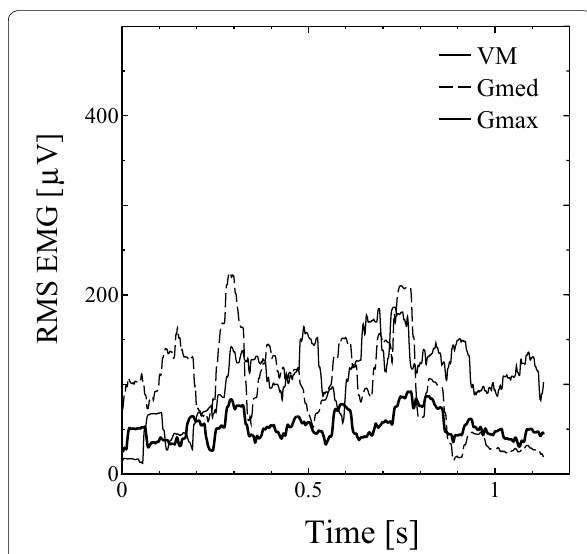
Fig. 19 RMS EMG during isotonic exercise. The target force was 0 N